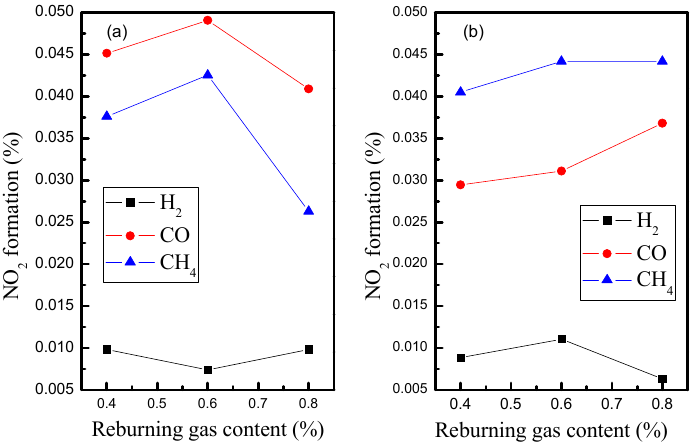
formation, reburning gas and oxygen content 2 = 6% (N O = 2000 ppm, N 2 2